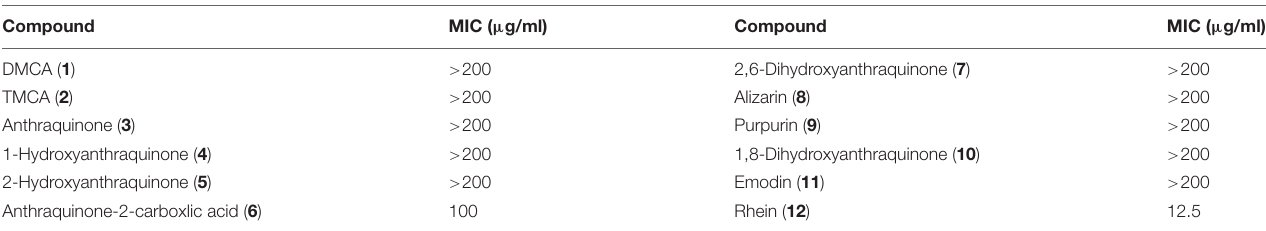
FIGURE 2 | The formation of MRSA biofilms after treatment with compound 1 or 2 staining by CV. The biofilm inhibition activity results after treatment with compound 1 or 2 (200 µ g/ml) in a 96-well plate (A) and different concentrations of compound 1 (50 and 200 µ g/ml) in a 24-well plate (B) . The same volume of DMSO was used as negative control. TABLE 1 | Minimum inhibitory concentrations of